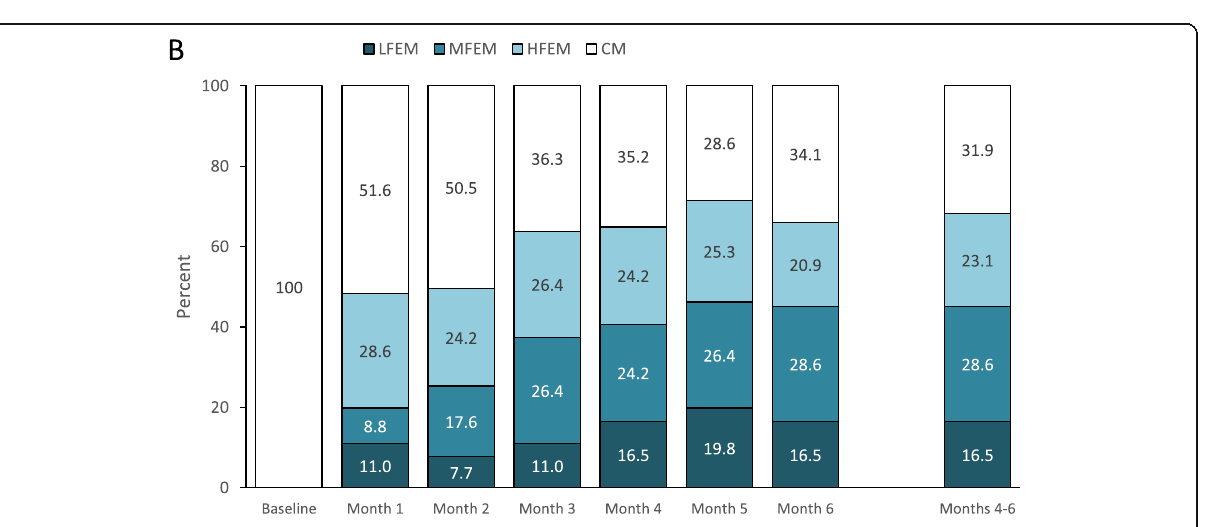
Fig. 1 Rates of conversion to episodic migraine at Months 4 – 6 and after each month of treatment according to monthly headache days. HFEM indicates high-frequency episodic migraine (8 – 14 monthly headache days); LFEM, low-frequency episodic migraine (0 – 3 monthly headache days); MFEM, medium-frequency episodic migraine (4 – 7 monthly headache